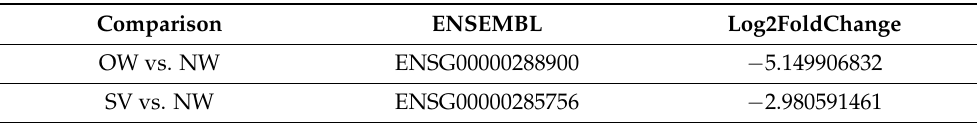
Table 2. Novel lncRNAs found in the study. DEGs and their respective expressions (Log2FoldChange) obtained from RNA-seq in the following comparisons: OW vs. NW, SV vs. NW, SV vs. OB, and SV vs.